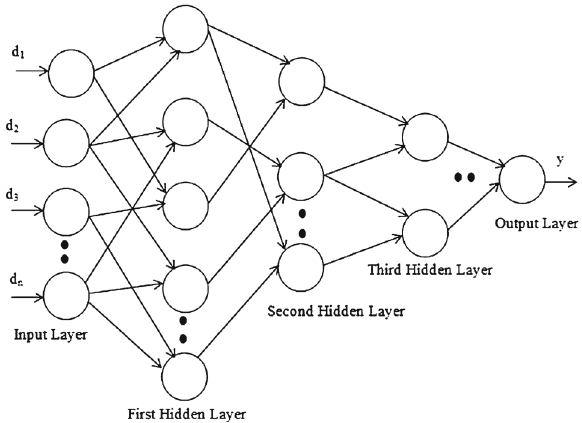
Fig. 1 Architecture of GMDH